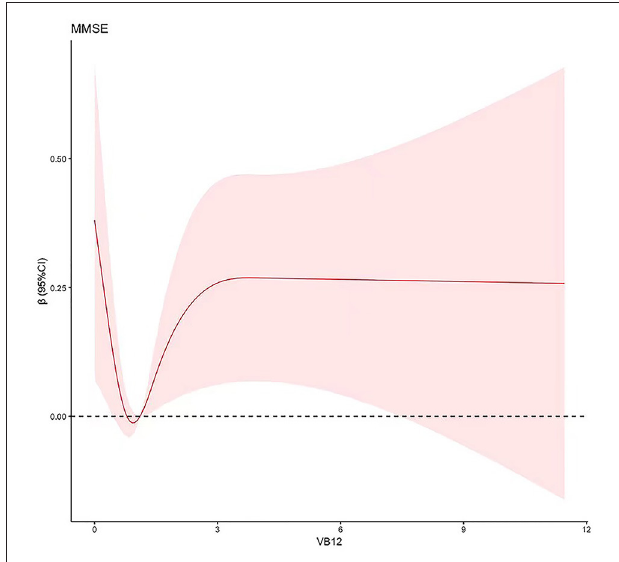
FIGURE 2 | Dose-response relationship between vitamin B 12 and MMSE. Adjusted for age, sex, education, BMI, smoking, drinking, hypertension, hyperlipidemia, diabetes, CVD, and other nutrient patterns using RCS models. The shaded area represents the estimated relative risk and the 95% CI. MMSE, Mini-Mental State Examination; BMI, body mass index; CVD, cerebrovascular diseases; CI, confidence